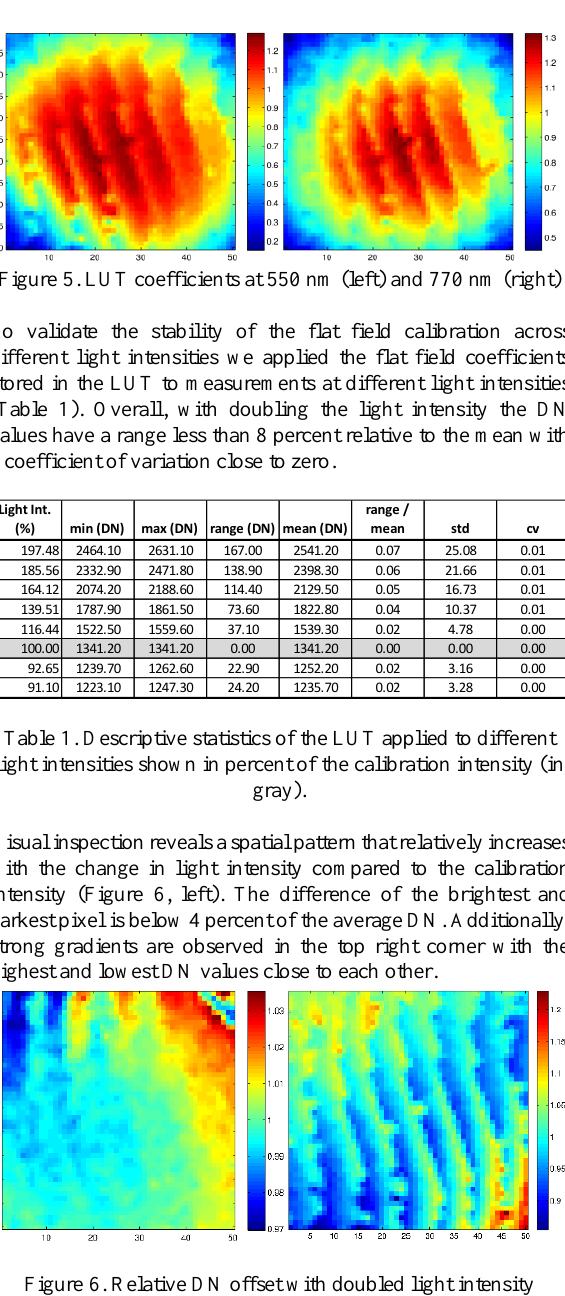
Figure 6. Relative DN offset with doubled light intensity compared to the calibration (left). Artefacts after applying the flat-field coefficients to an in-field measurement of a Zenith panel (right).